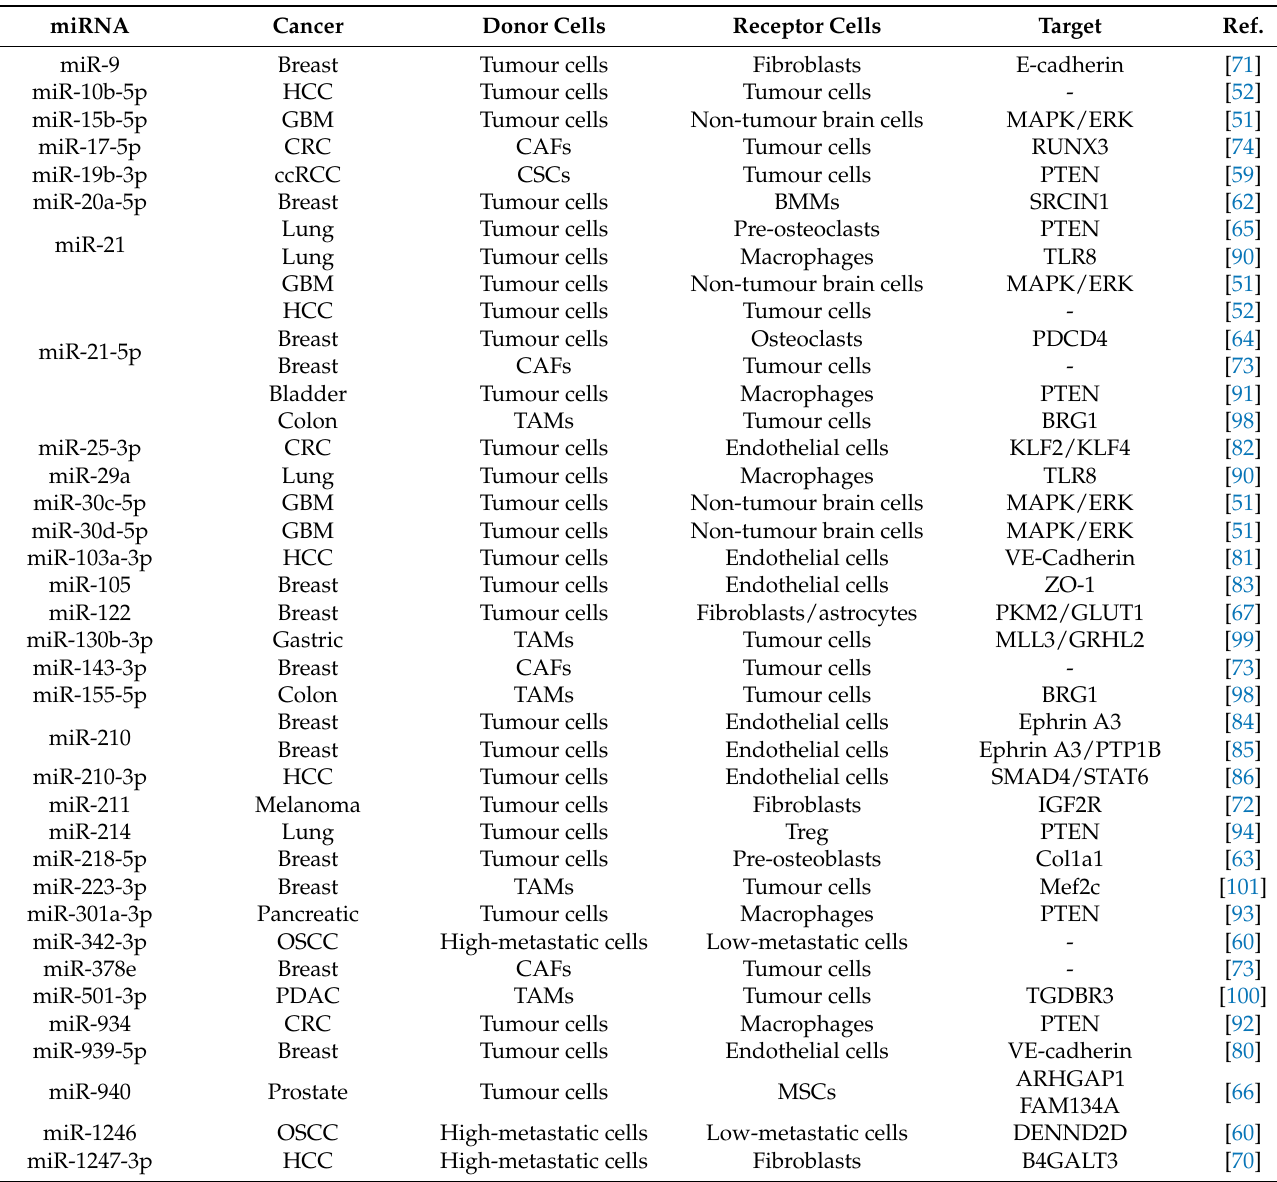
Table 1. List of miRNAs associated with metastasis and